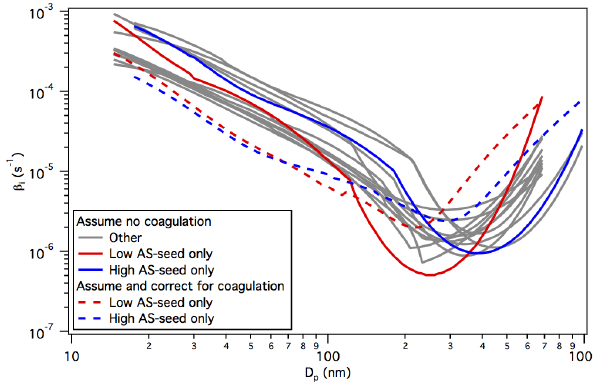
Figure 1. Particle wall deposition coefficients ( β i ) measured dur- ing the low AS-seed-only and high AS-seed-only experiments in GTEC. Also shown are the particle wall deposition coefficients (la- beled “Other”) measured in previous routine monthly AS-seed-only experiments in the chamber. These previous routine monthly AS- seed-only experiments were performed using either a 0.008M AS or a 0.1M AS solution. Coagulation-corrected particle wall deposi- tion coefficients (see Pierce et al., 2008, and main text for details) are also shown, using dashed